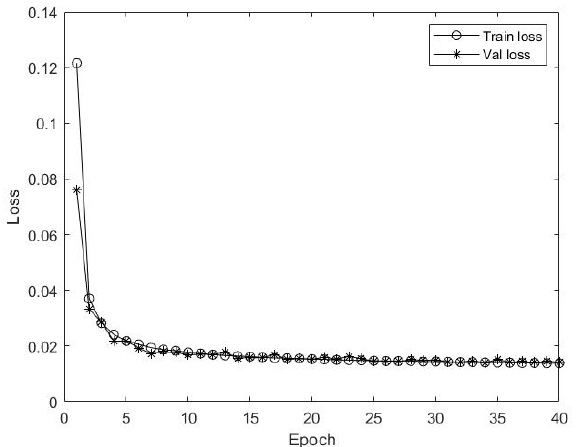
Figure 8. The loss curves of PFSegIris on the mixed iris training set and validation set.